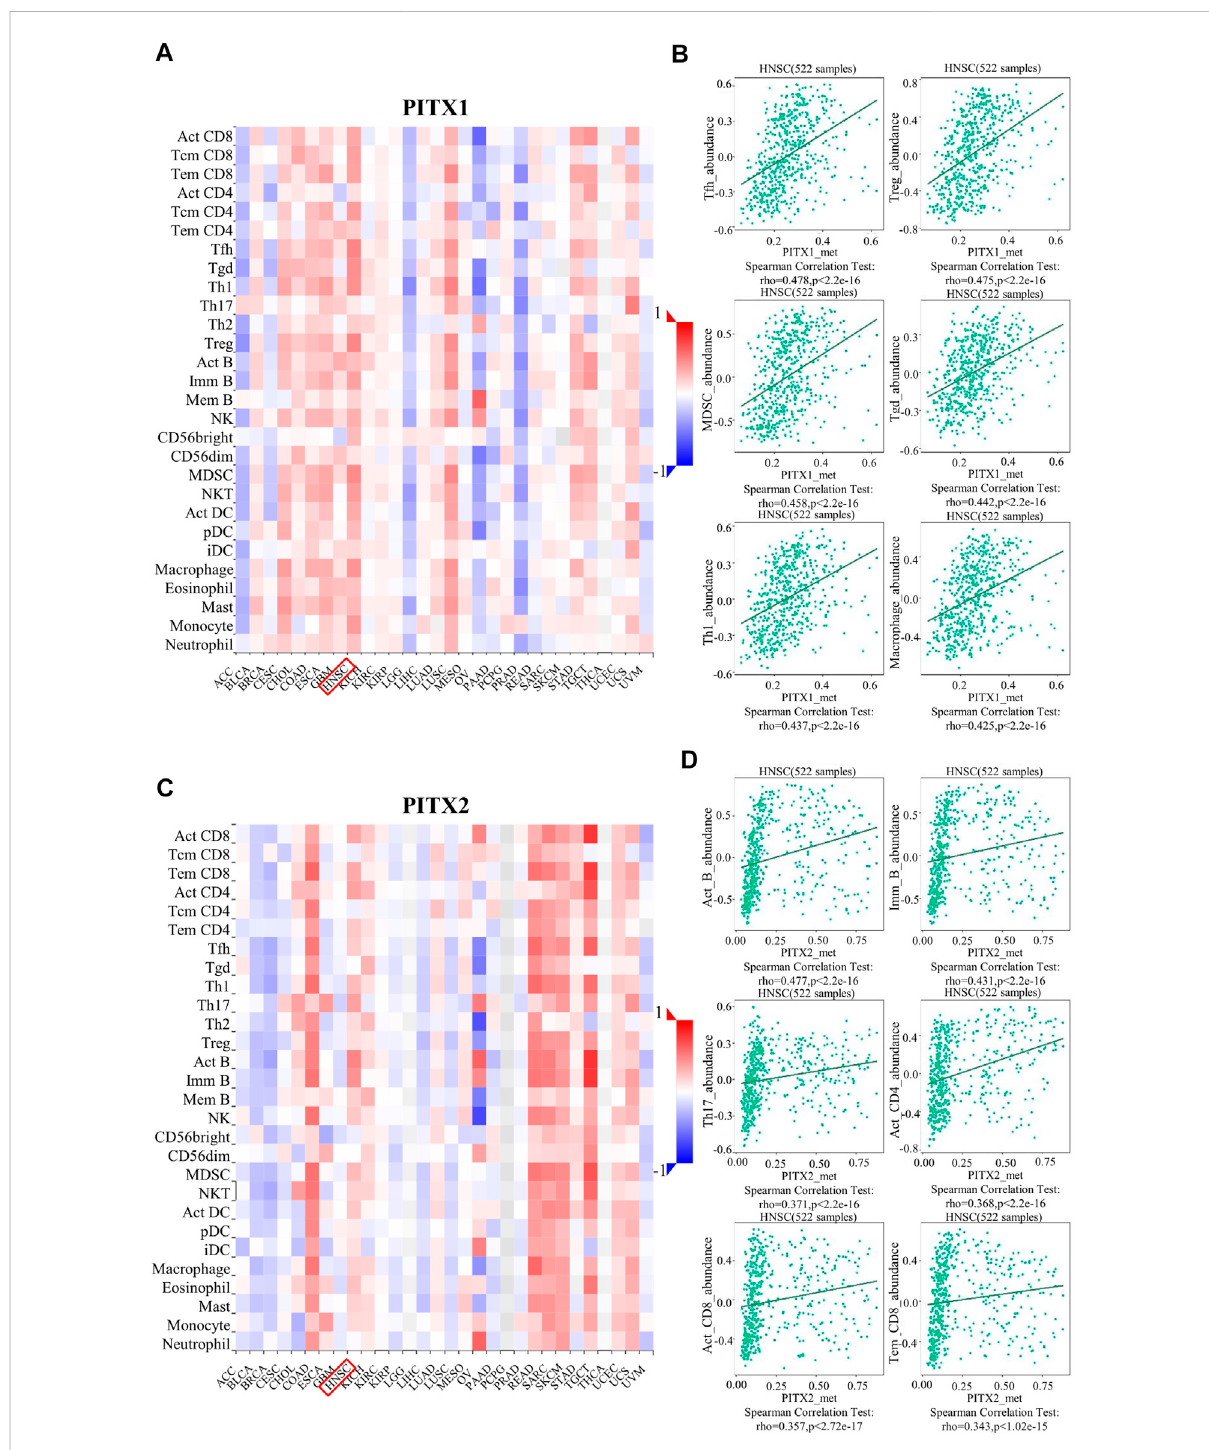
FIGURE 9 TISIDB analysis of correlations between PITX1 and PITX2 methylation and immune cells in fi ltration across human cancers. (A) The relationship between PITX1 methylation and 28 types of TILs across various human cancers. (B) The top six TILs displaying the strongest Spearman ’ s correlation with PITX1 methylation in HNSC. (C) The relationship between PITX2 methylation and 28 types of TILs across various human cancers. (D) The top six TILs displaying the strongest Spearman ’ s correlation with PITX2 methylation in HNSC. Act_CD8, activated CD8 + T cells; Tcm_CD8, central memory CD8 + T cells; Tem_CD8, effector memory CD8 + T cells; Act_CD4, activated CD4 + T cells; Tcm_CD4, central memory CD4 + T cells; Tem_CD4,effectormemoryCD4 + Tcells;Tfh,Tfollicularhelpercells;Tgd,gammadeltaTcells;Th1,type1Thelpercells;Th17,type17Thelpercells; Th2, type 2 T helper cells; Treg, regulatory T cells; Act B, activated B cells; Imm_B, immature B cells; Mem_B, memory B cells; NK, natural killer cells; CD56 bright , CD56 bright NK cells; CD56 dim , CD56 dim NK cells; MDSC, myeloid derived suppressor cells; NKT, natural killer T cells; Act DC, activated dendritic cells; pDC, plasmacytoid DCs; iDC, immature DCs; Mast, mast